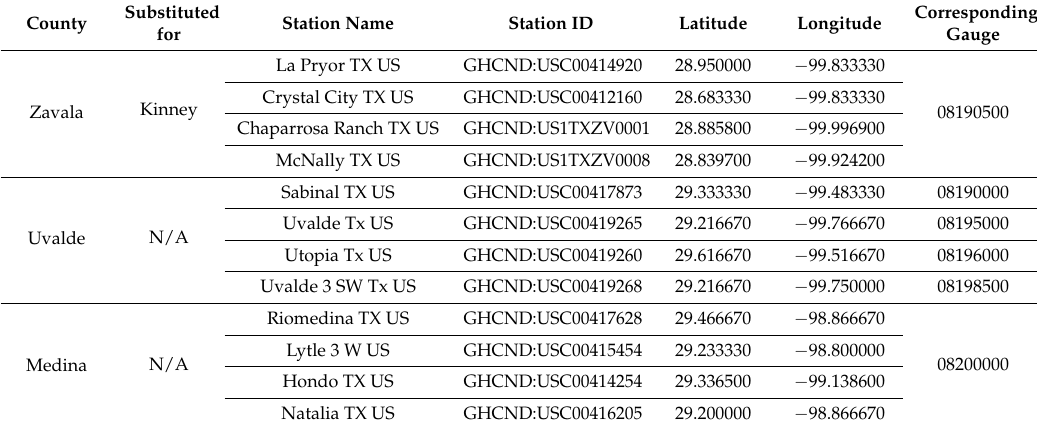
Figure 5. Streamflow variability from 1970–2014 (median values for this time period are shown using the diamond plus symbol). Table 2. Consolidated precipitation